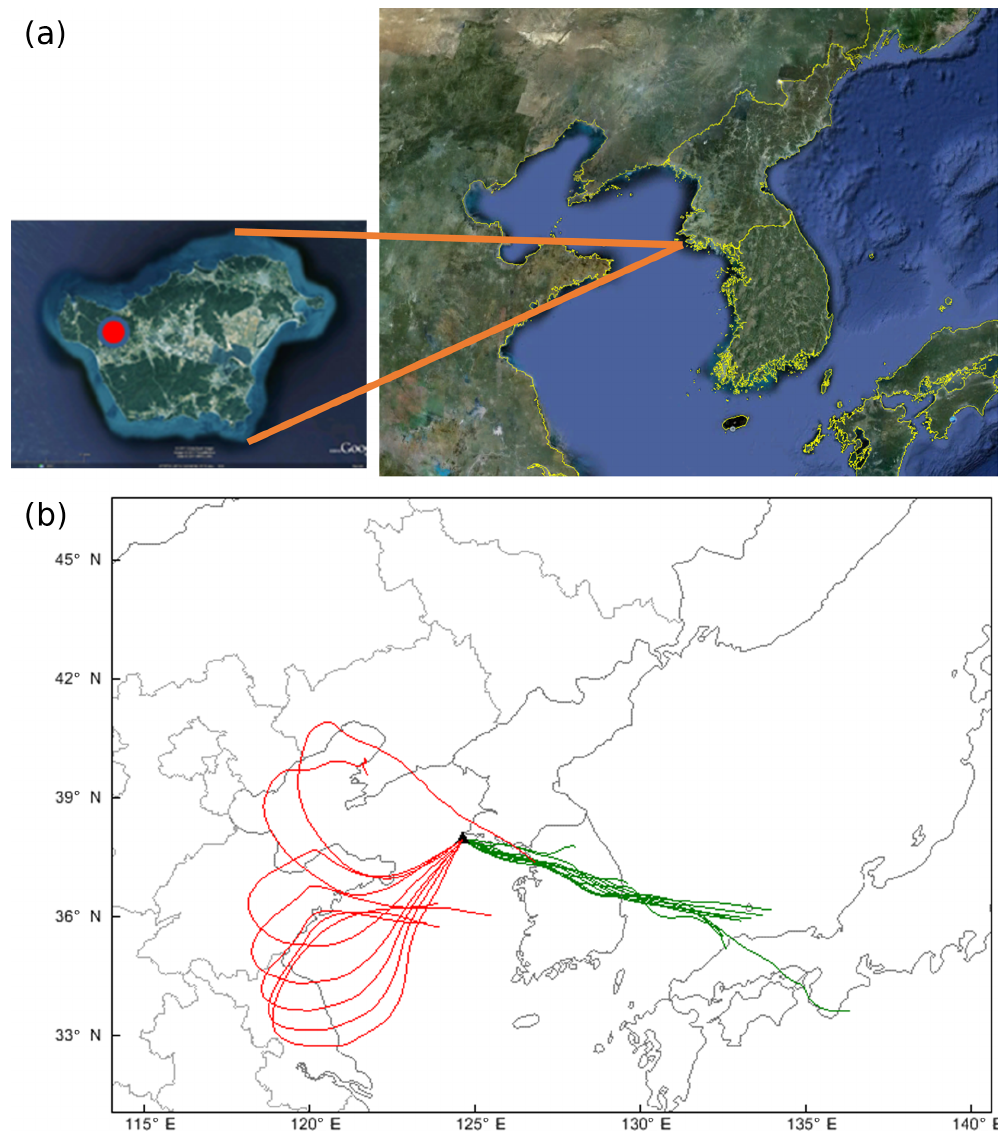
Figure 1. (a) The location of the measurement site on Baengnyeong Island, the northernmost island in South Korea. The red circle indicates the measurement station location. (b) 72h backward trajectory for the two episodes. Green represents the organics-dominated episode during 6 August 11:00LT to 7 August 2011 09:00LT, while red represents the sulfate-dominated episode during 9 August 01:00LT to 9 August 2011